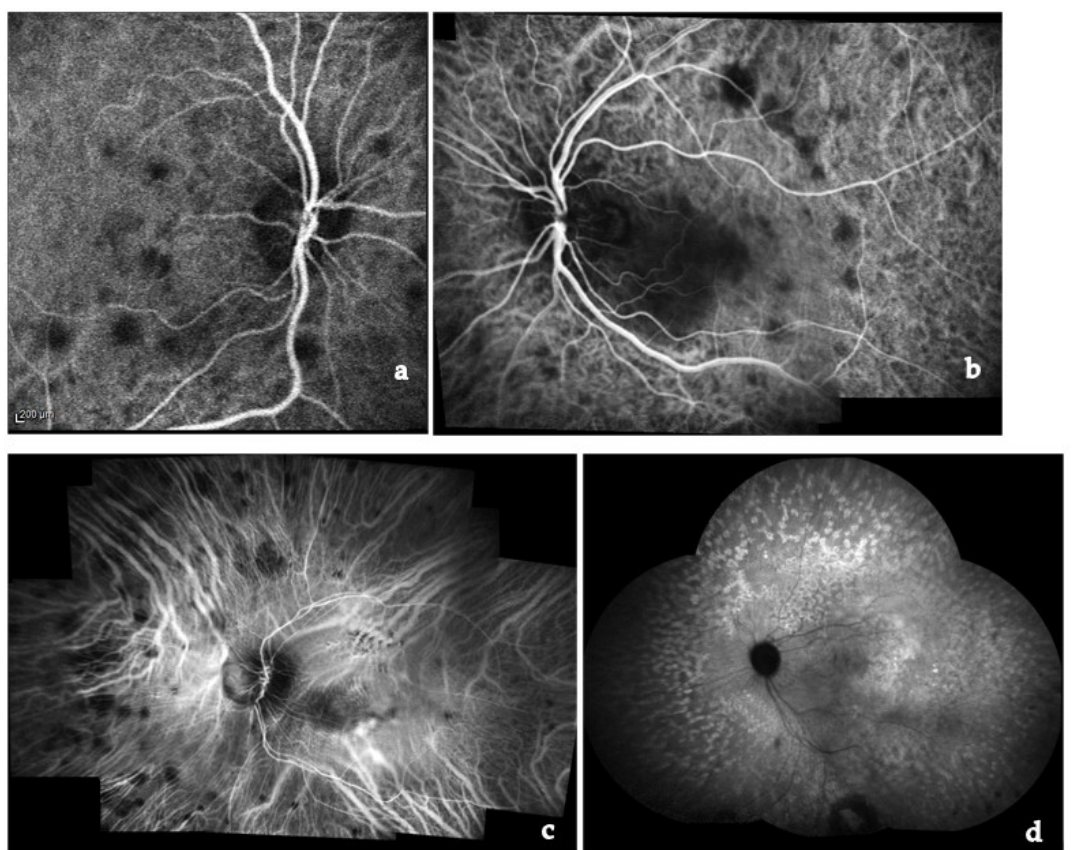
Figure 9. Early phase of ICGA showing multiple hypofluorescent active choroidal granulomas ( a , b ); Late phase of ICGA with multiple granulomas evident in the whole retina ( c , d ).